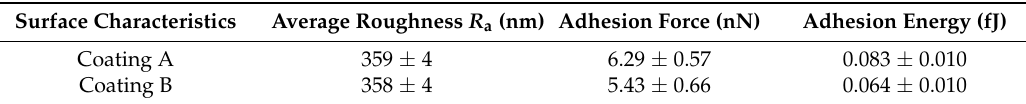
Table 2. Average roughness, adhesion force and adhesion energy of the superhydrophobic aluminum